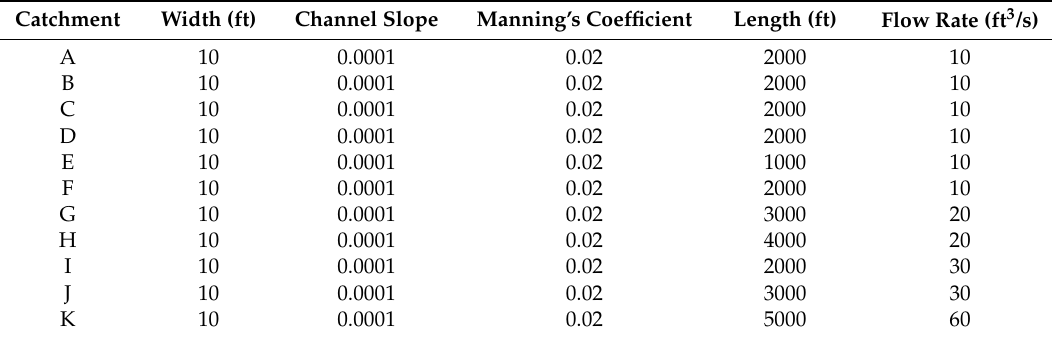
Figure 1. Hypothetical river network A. Table 1. Hydraulic characteristics of river network A.